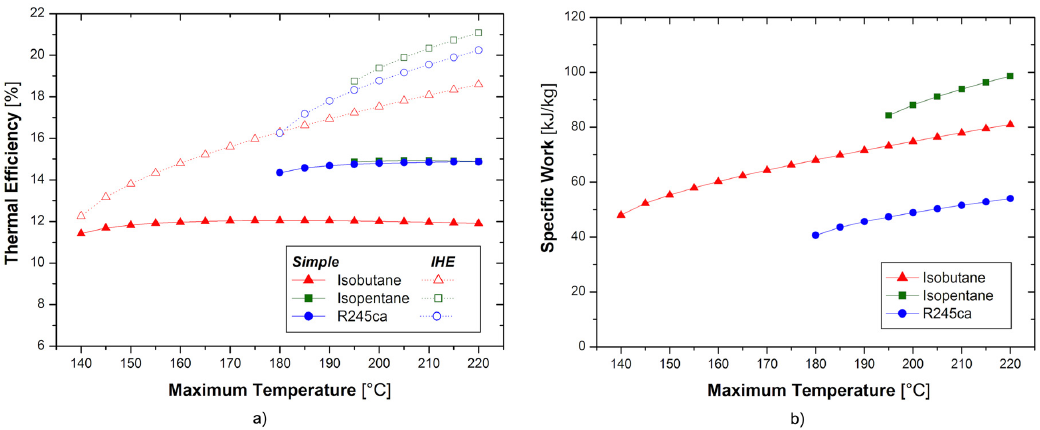
Figure 5. Effect of maximum temperature on ORC efficiency ( a ) and specific work ( b ) (transcritical cycle).